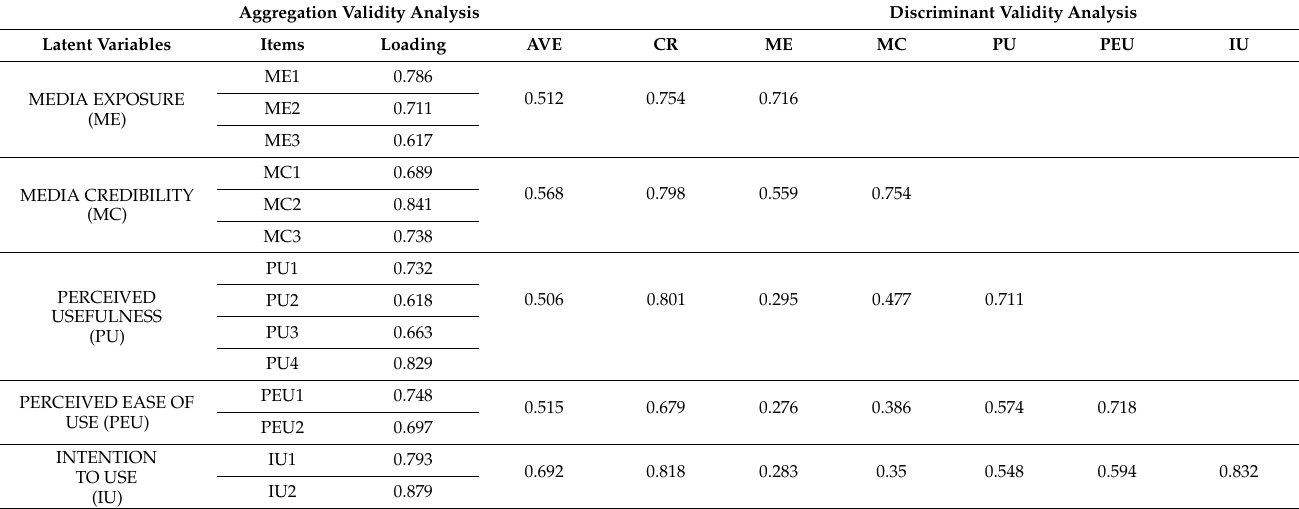
Table 4. Confirmatory factor analysis.